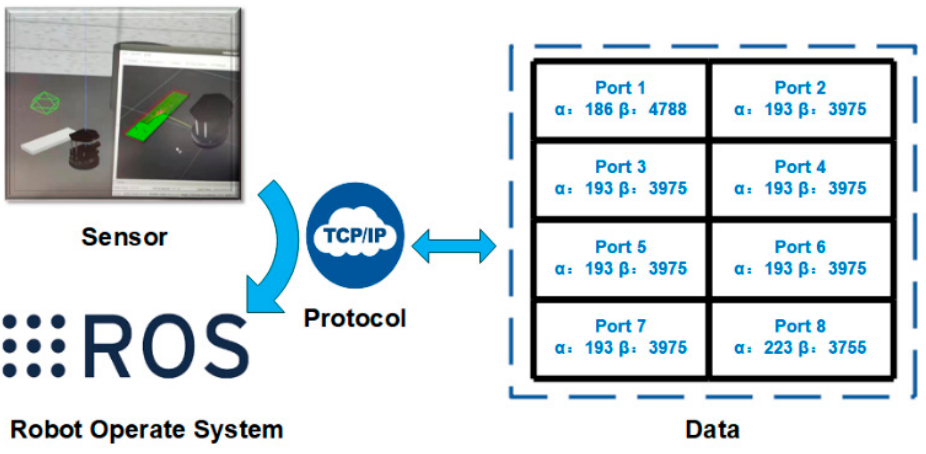
Figure 7. The process of communicating radiation-detection data